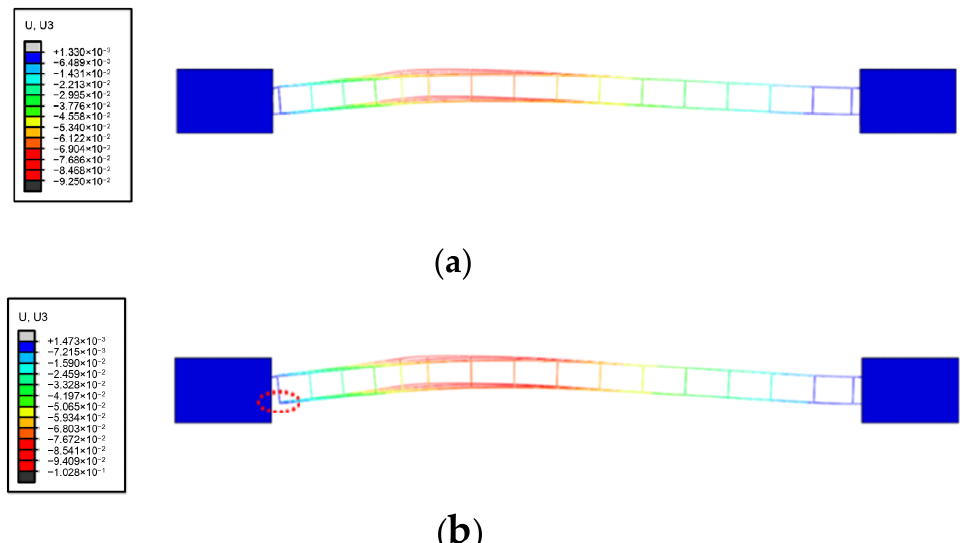
Figure 21. Displacement nephograms of the grouting sleeve and reinforcement under an explosive